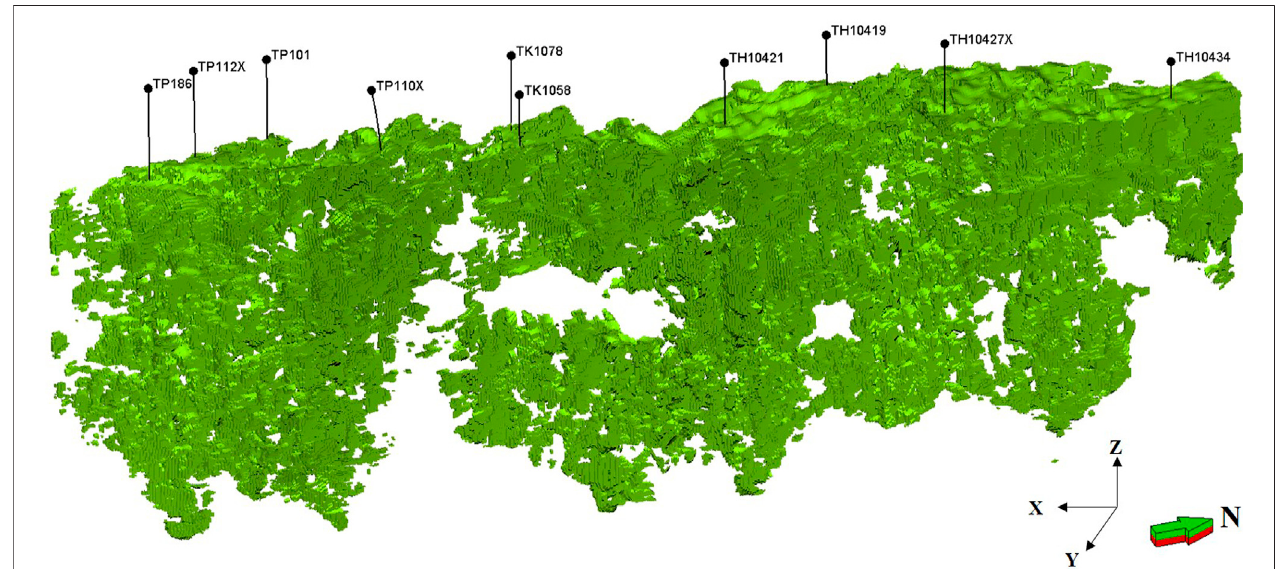
FIGURE 6 | Fault-controlled paleokarst envelope model in the TP12CX